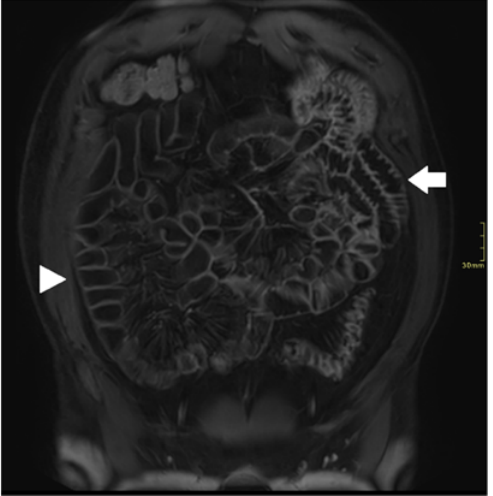
Figure 2. Coronal fat-suppressed T1 post-contrast sequence of a 35-year-old male with small bowel CD; optimal distension and no motion artifacts in proximal (arrowhead) and distal (arrow) small bowel.